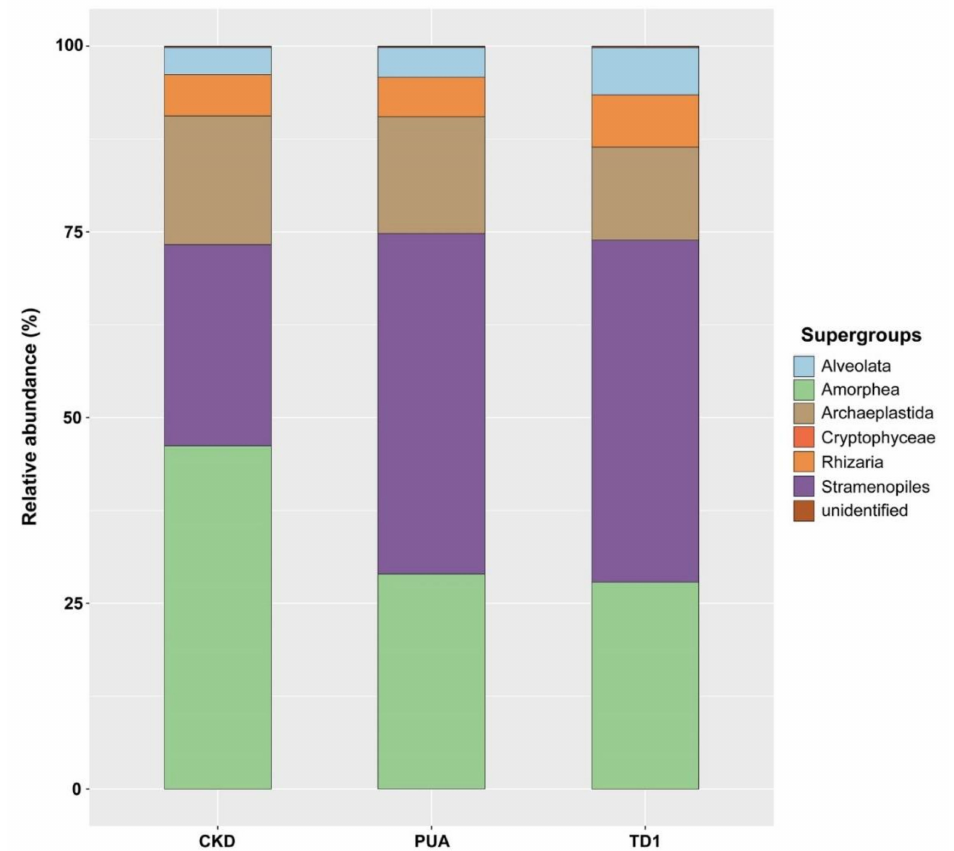
Figure 4. Results from 18S rDNA amplicon analysis of Cladophora sp. collected from Nan River, sites CKD, PUA, and TD1, showed that supergroups and their relative abundance were varied. The five supergroups with the highest relative abundance at site CKD were Amorphea (46.19%), Stramenopiles (27.10%), Archaeplastida (17.33%), Rhizaria (5.55%), and Alveolata (3.66%). Supergroups for site PUA were Stramenopiles (45.84%), Amorphea (28.95%), Archaeplastida (15.71%), Rhizaria (5.33%), and Alveolata (4.01%). Supergroups for site TD1 were Stramenopiles (46.04%), Amorphea (27.83%), Archaeplastida (12.55%), Rhizaria (7.02%), and Alveolata